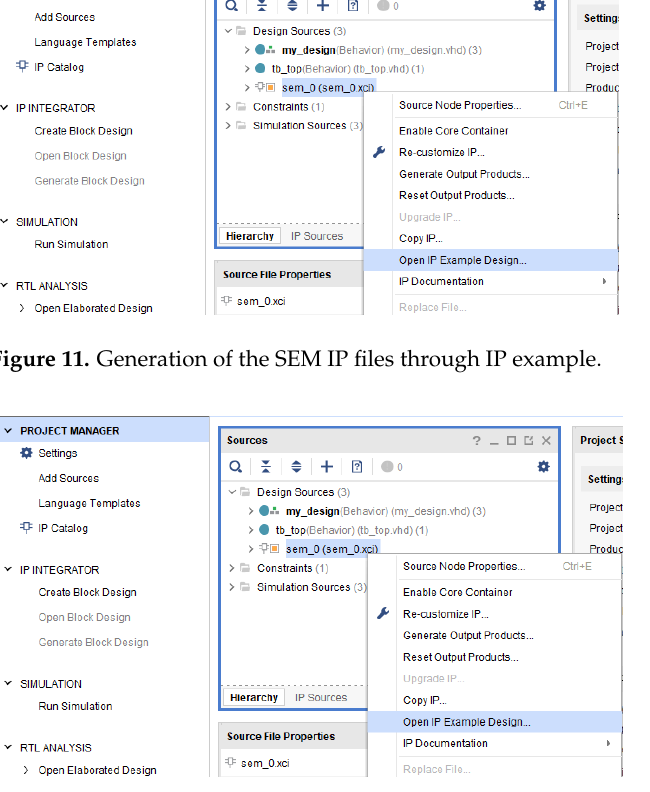
Figure 12. SEM example supported by Xilinx.